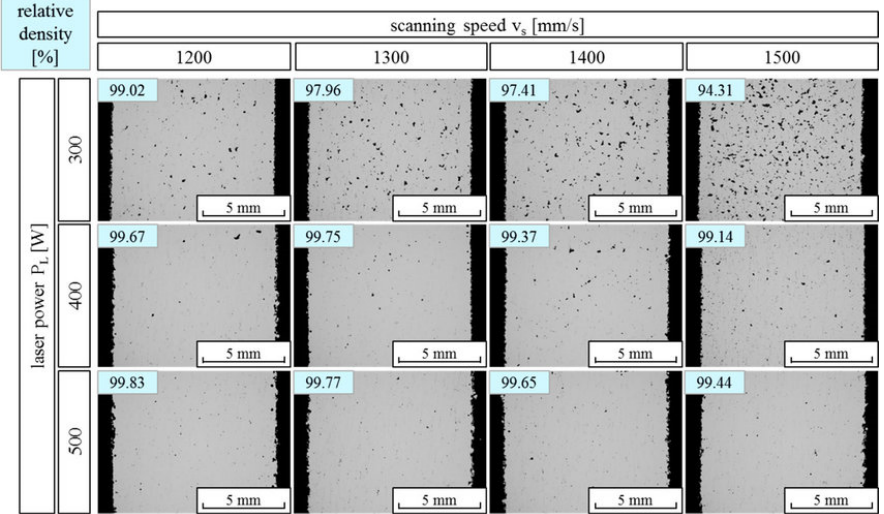
Figure 46. Comparison of SEM images of polished SLM 7075 alloy specimens, presented along with relative densities (top left of the images) obtained for different combinations of laser power and